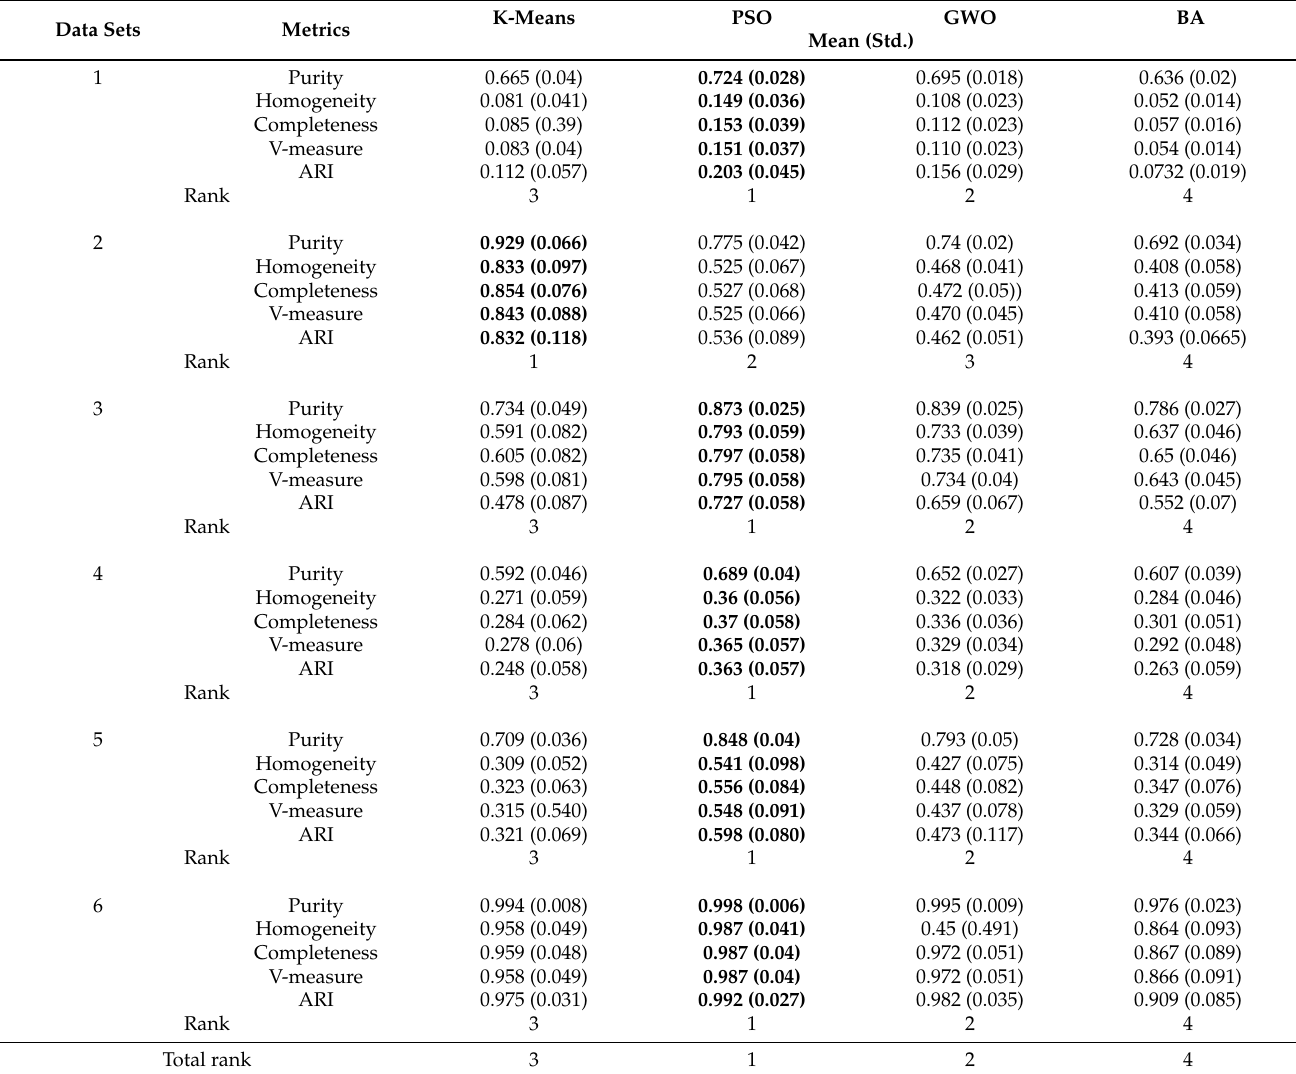
Table 4. Mean and standard deviation results for all iteration numbers for clustering algorithms with six data sets. Data